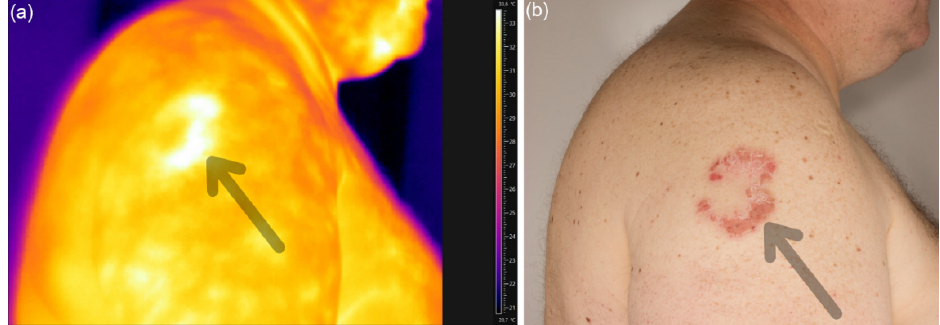
Figure 3. Thermograms of patient with psoriatic lesion ( a ) and clinical photography of that area ( b ).